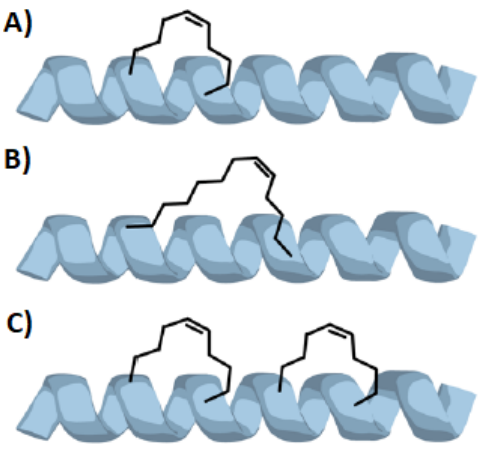
Figure 3. Example of i, i + 4 ( A ), i, i + 7 ( B ) and double i, i + 4 ( C ) stapling